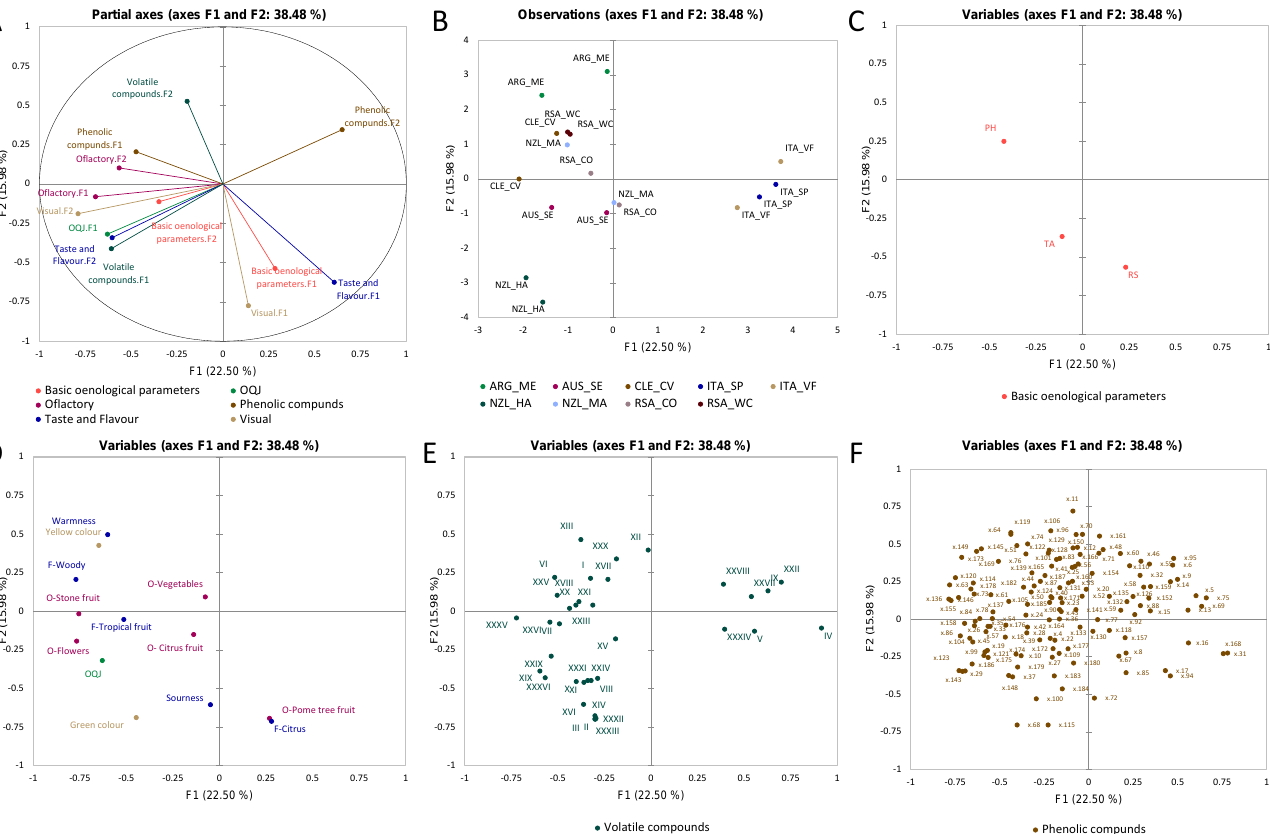
Variables (axes F1 and F2: 38.48 %)